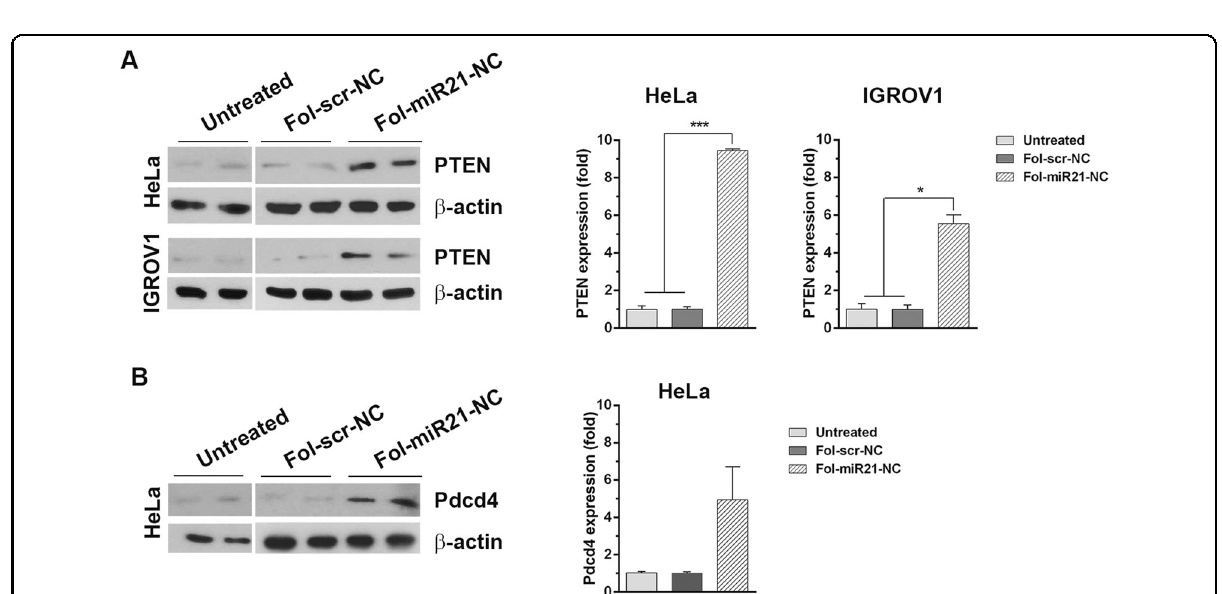
Fig. 4 Expression level of PTEN and Pdcd4 miR-21 target proteins. A Western blots of PTEN in HeLa and IGROV1 cells lysates, treated or not with Fol-NCs for 48 h. B Western blot of Pdcd4 on lysates from HeLa cells treated or not with Fol-NCs for 72 h. Densitometric analysis of three different experiments are shown on the right panels. Values are expressed as mean ± S.E.M. Statistical signi fi cance: * P < 0.05 and *** P < 0.001 (Student ’ s t